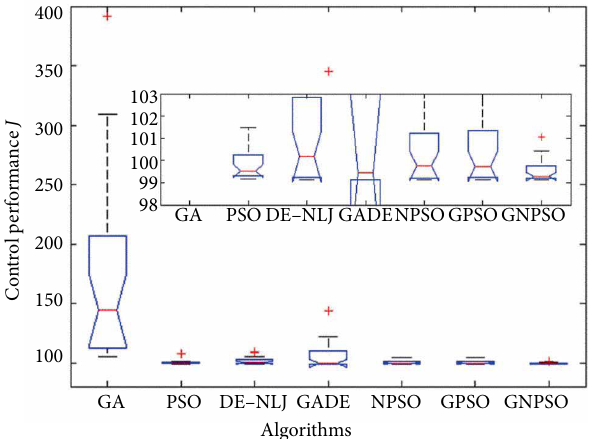
Figure 6: ANOVA tests of the control performance obtained by different algorithms for nonlinear wing vibration system.